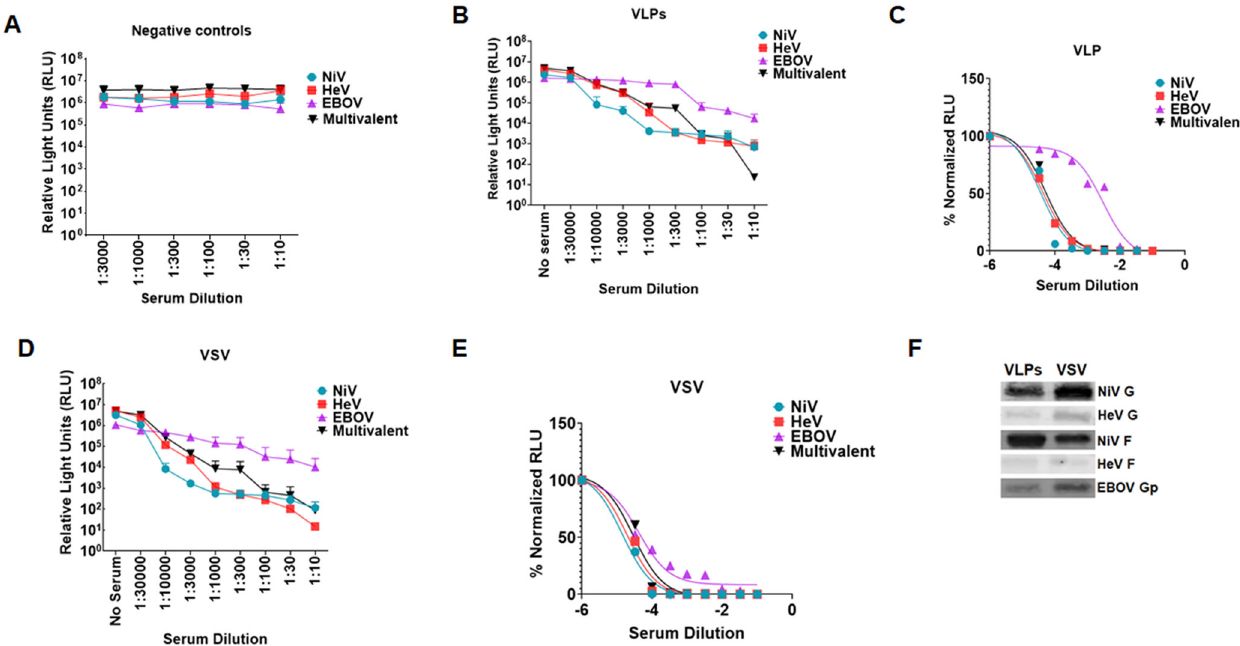
Fig. 6 Multivalent VLPs and pseudotyped VSV incorporating NiV F/G, HeV F/G, and EBOV GP elicited neutralizing antibodies in hamsters. A . Negative control hamsters were vaccinated with bald VLPs. Serum for the hamsters ’ terminal bleed was used to neutralize monovalent NiV F/G, HeV F/G, EBOV GP, and the multivalent pseudotyped VSV particles and entry of the virus into the cells was analyzed by Renilla Luciferase assay. The mean neutralization read out for the monovalent and multivalent pseudotyped VSV was calculated and graph plotted using Graphpad software. B Monovalent and multivalent pseudotyped VSV were neutralized with different dilutions of sera from hamsters vaccinated with multivalent VLP vaccine. Virus neutralization was done in a similar manner as the negative controls. The average neuralization read outs were calculated and graph derived using Prism Graphpad software. C Hamsters were vaccinated with the multivalent pseudotyped VSV. Sample processing was done as for the negative controls. The mean neutralization read out was calculated and graph derived using Prism graphpad software. D , E Normalized graphs for sera from hamsters vaccinated with the multivalent VLPs and pseudotyped VSV. F Forty microliters of VLP and pseudotyped VSV preparations were analyzed by Western blotting to compare incorporation of glycoproteins following observation that pseudotyped VSV was eliciting a relatively stronger immune response compared to